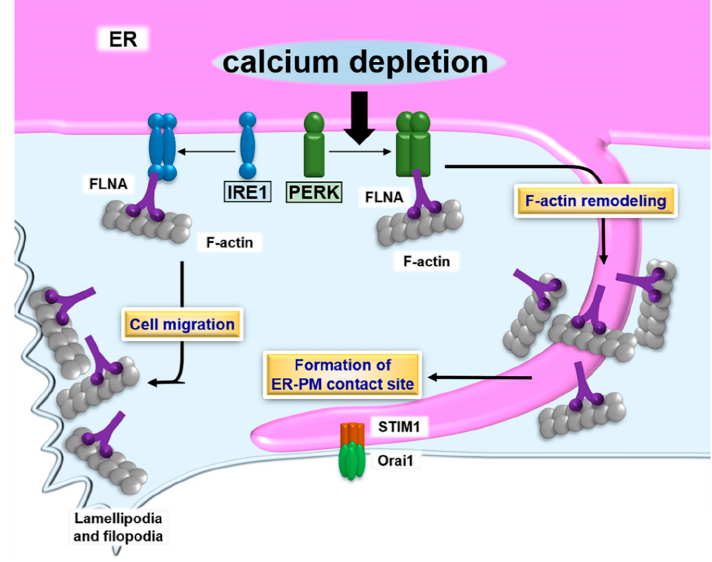
Figure 2. Schematic describing the formation of ER- plasma membrane (PM) contact sites and the UPR. PERK dimerizes in response to calcium depletion in the ER lumen. The PERK dimer binds to filamin A (FLNA), followed by accelerating F-actin remodeling and formation of ER-PM contact sites containing stromal-interacting molecule 1 (STIM1) and Orai1. The contact sites promote calcium influx, which restores the calcium level to a normal value in the ER lumen. The IRE1 dimer also interacts with FLNA. Although the effect of the IRE1-FLNA interaction on the formation of ER-PM contact sites remains unclear, the binding of IRE1 to FLNA does modulate ER dynamics and cell migration.